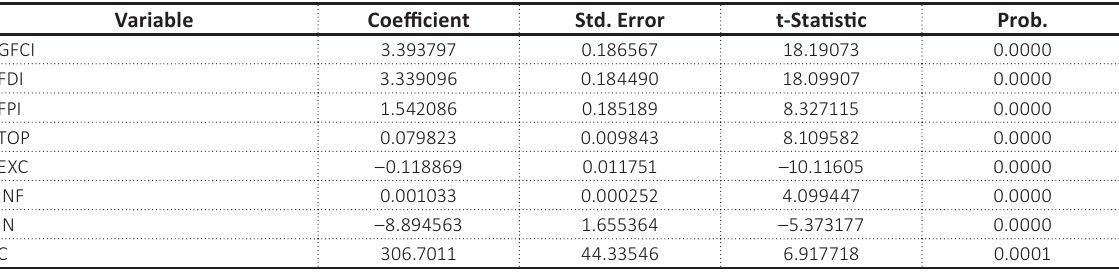
Table 5. Random effects test result